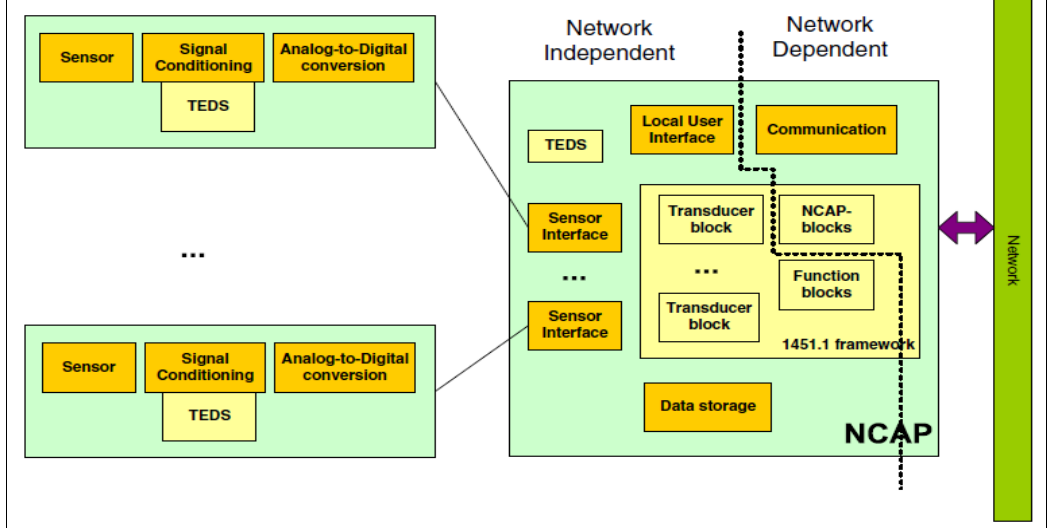
Figure 1. Sensor node and NCAP